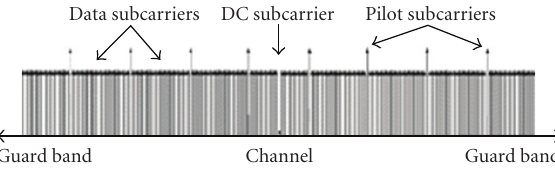
Figure 3: Frequency domain for